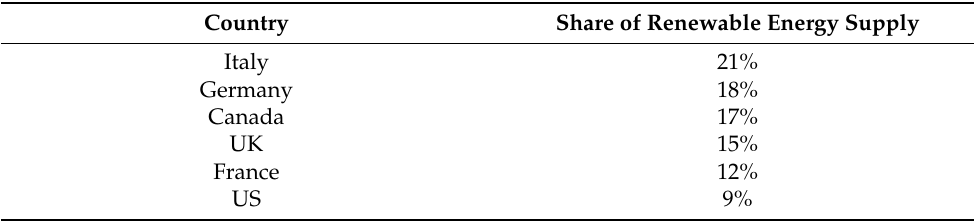
Table 12. Share of renewable energy supply by country. Country Share of Renewable Energy Supply